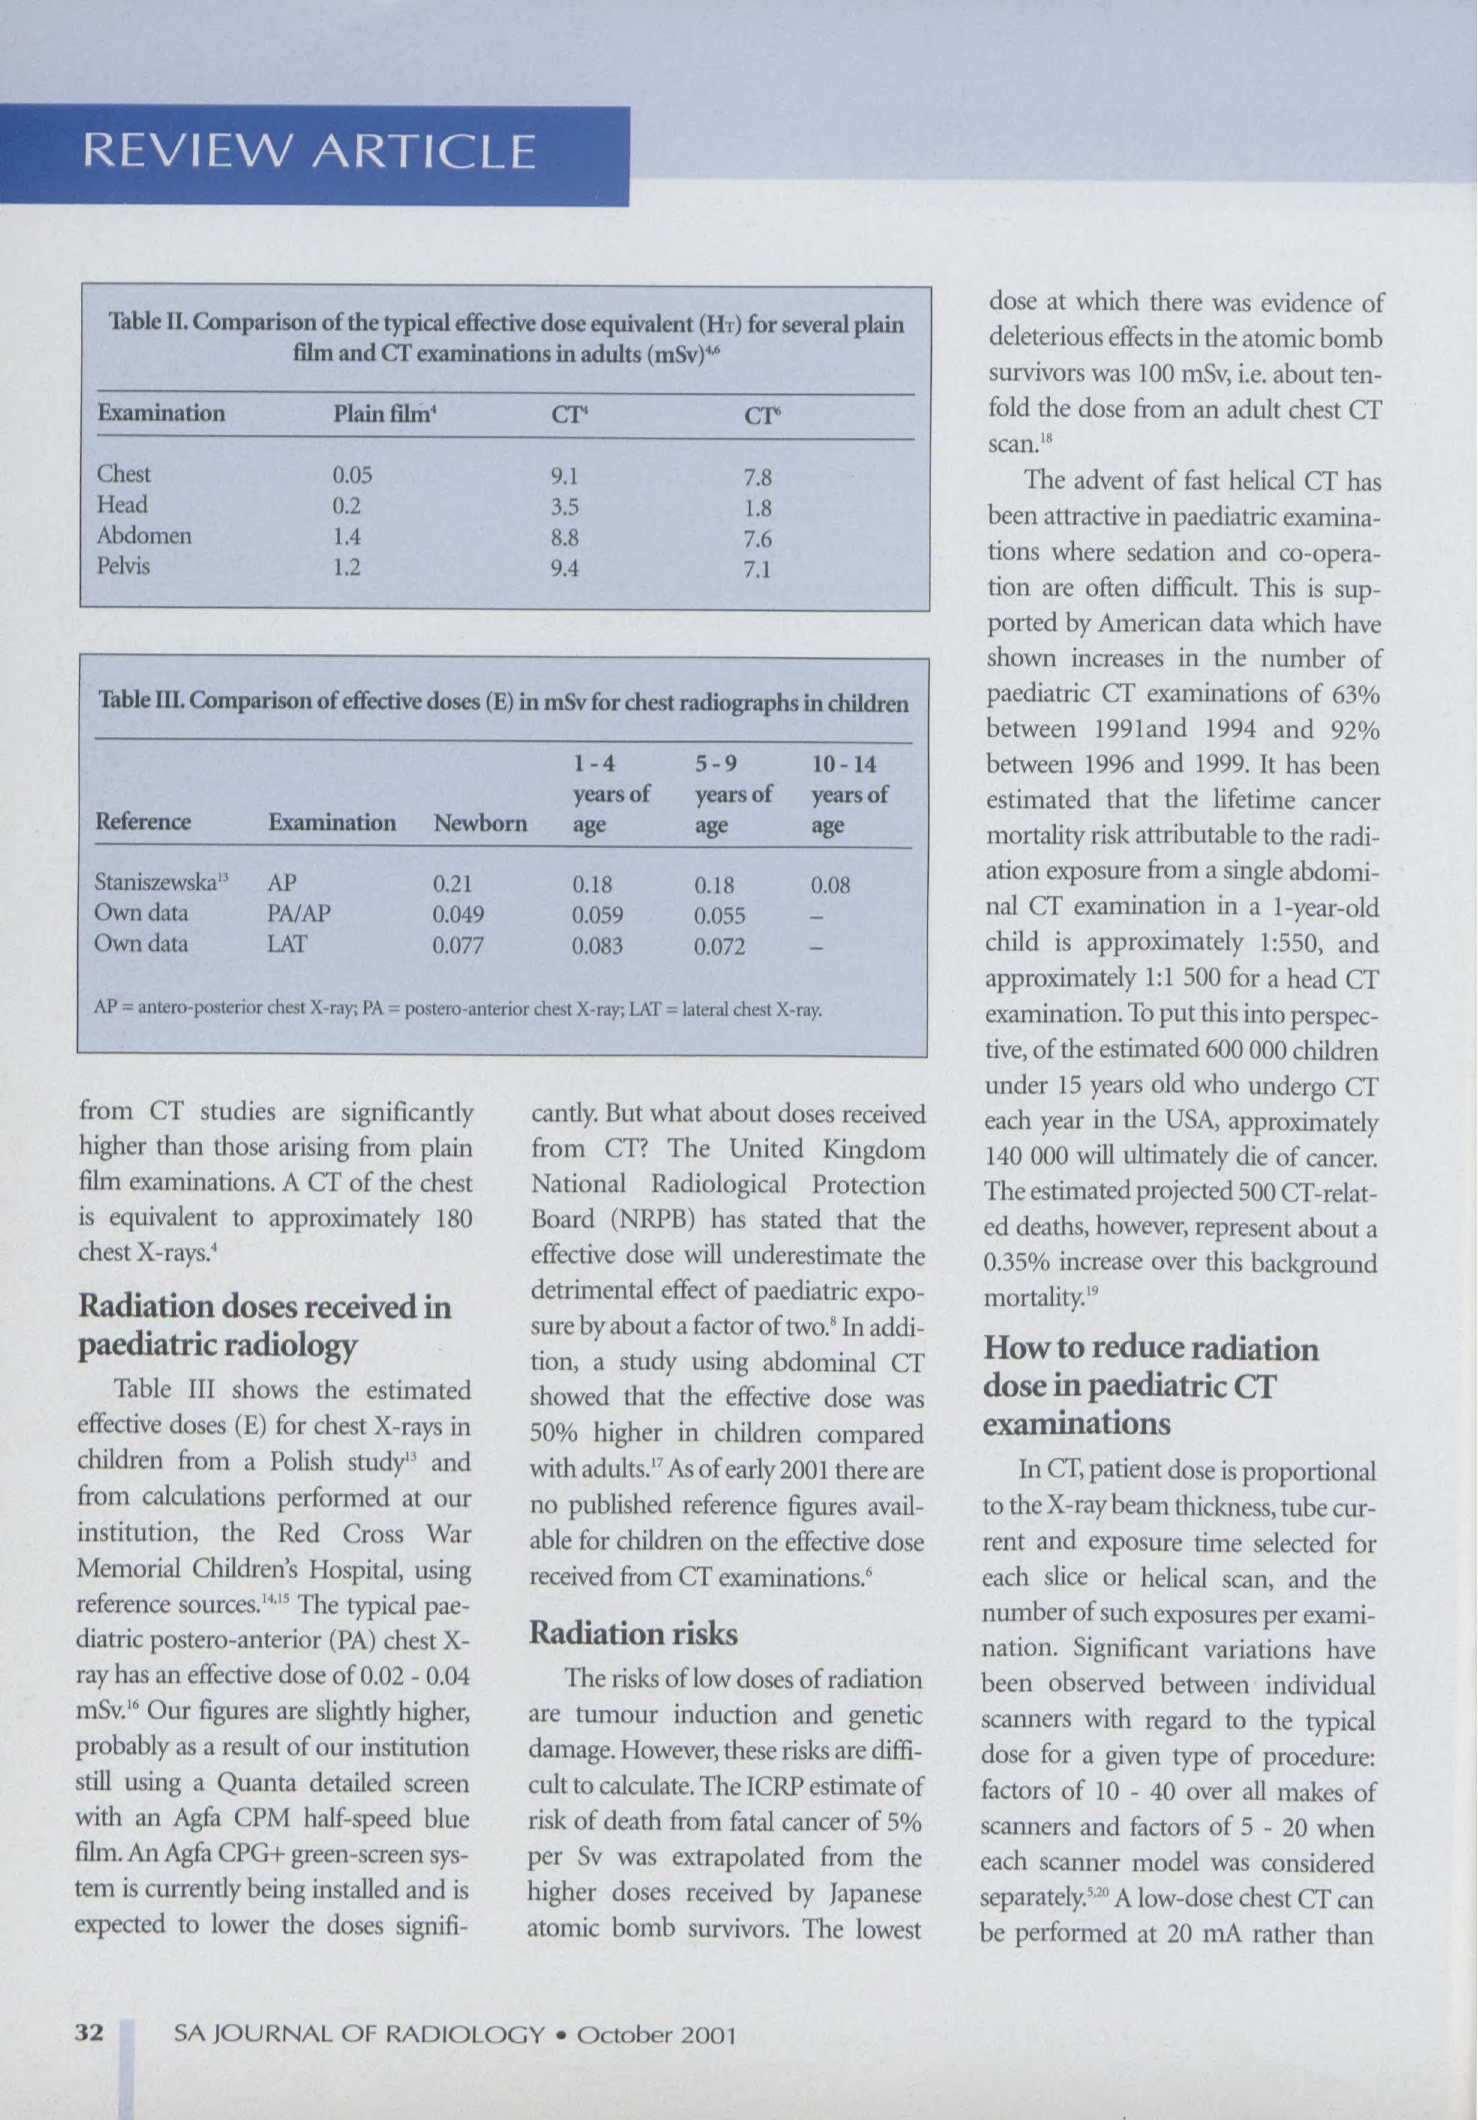
Table II. Comparison of the typical effective dose equivalent (HT) for several plain film and CT examinations in adults (mêv)"